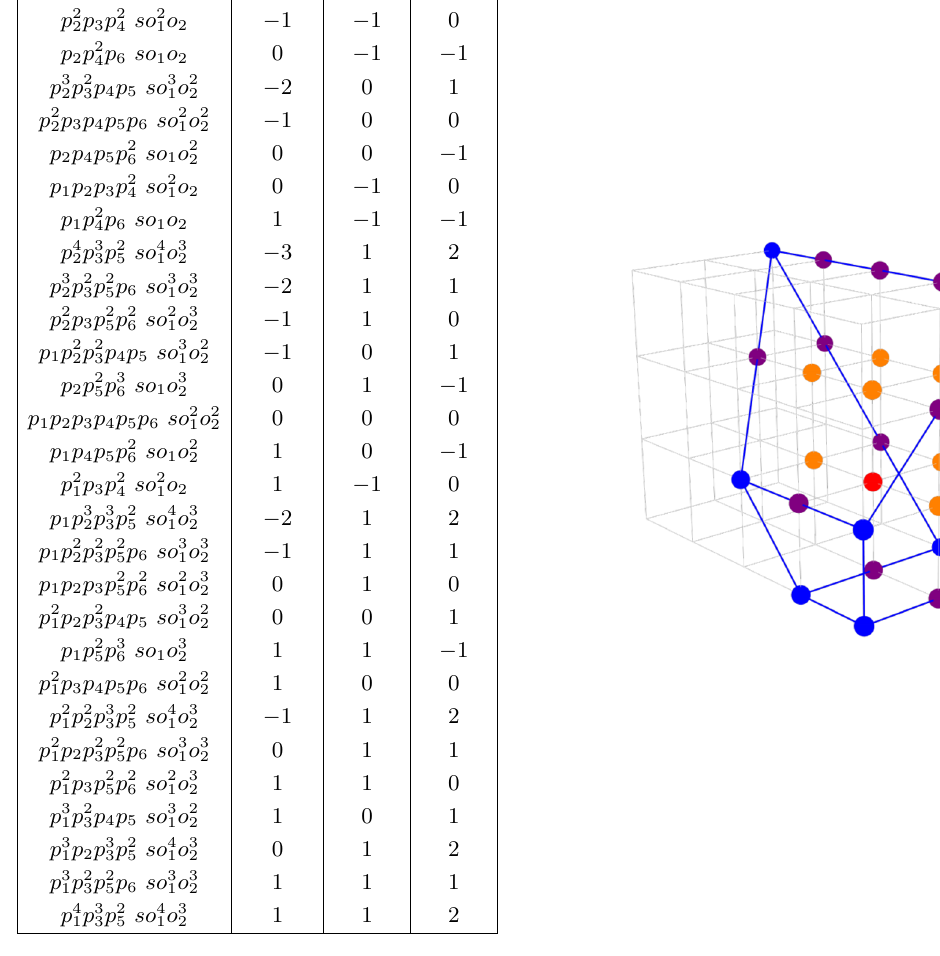
Table 40 . The generators and lattice of generators of the mesonic moduli space of Model 10 in terms of brick matchings with the corresponding flavor charges.